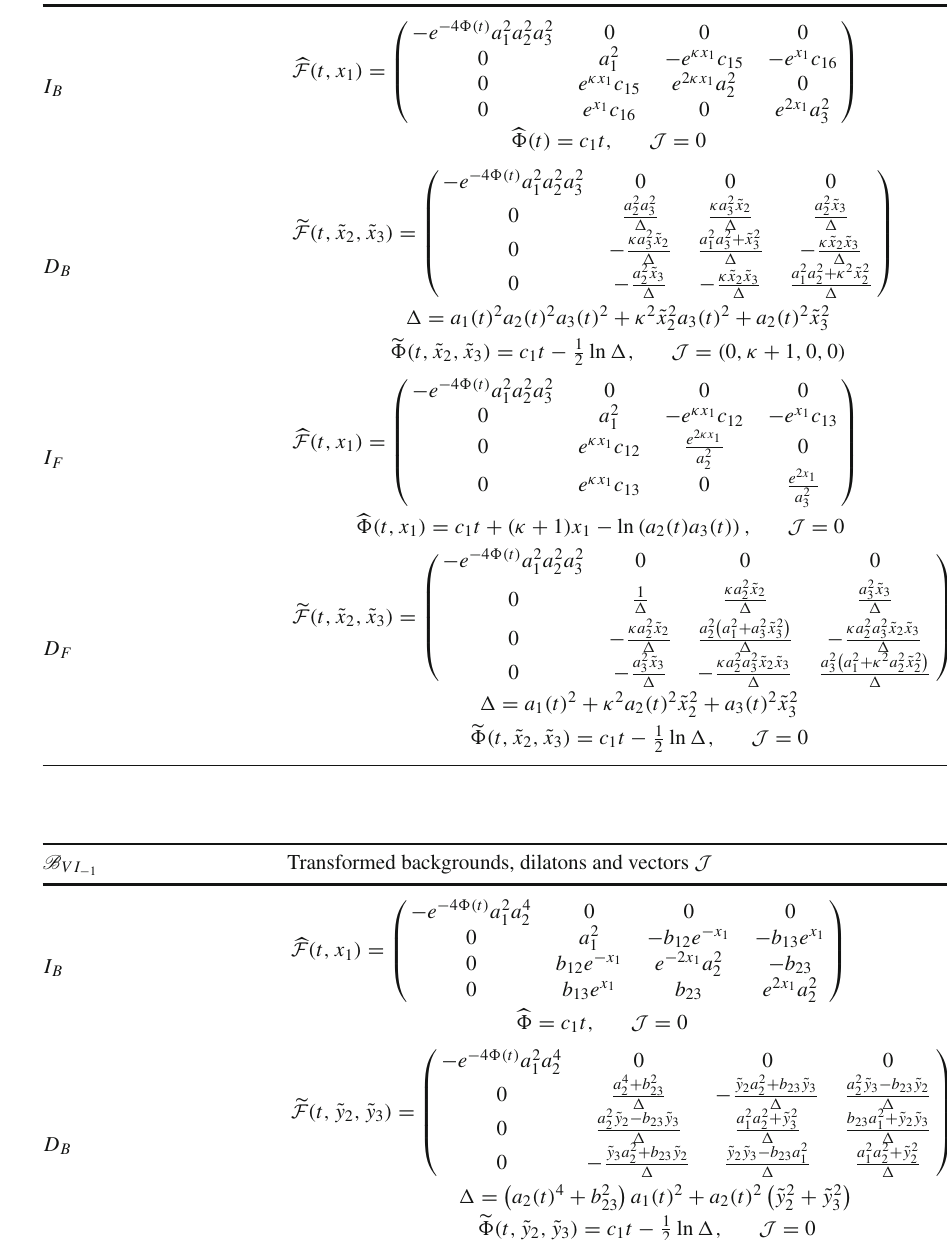
Poisson–Lie identities and dualities of Bianchi V I κ cosmology. Functions a i ( t ) are given by (44), κ (cid:8)= − 1 and (cid:14)( t ) = c 1 t